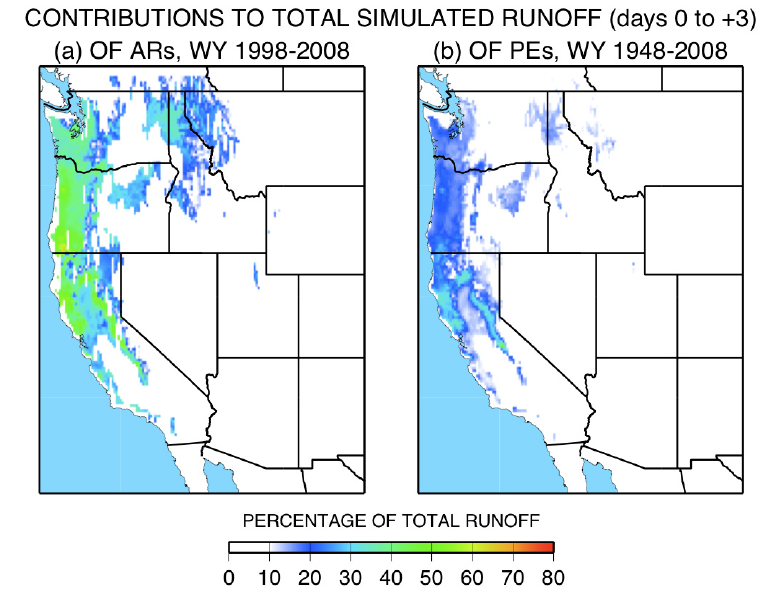
Figure 10. Same as main map in Figure 8, except based on VIC-simulated runoff-plus-baseflow, and for (a) AR episodes and (b) PE episodes; both maps are masked to show AR- (or PE-) episode contributions to runoff-plus-baseflow in areas where average simulated runoff-plus-baseflow during episodes is >0.5